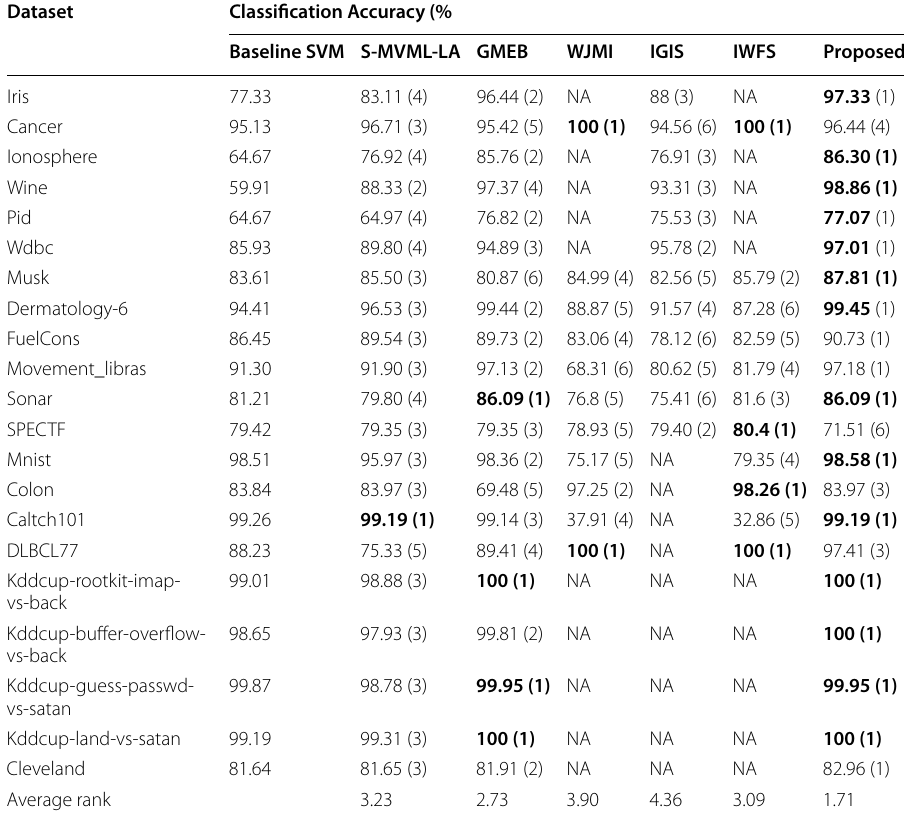
The numbers in bold are the best accuracies achieved on the dataset